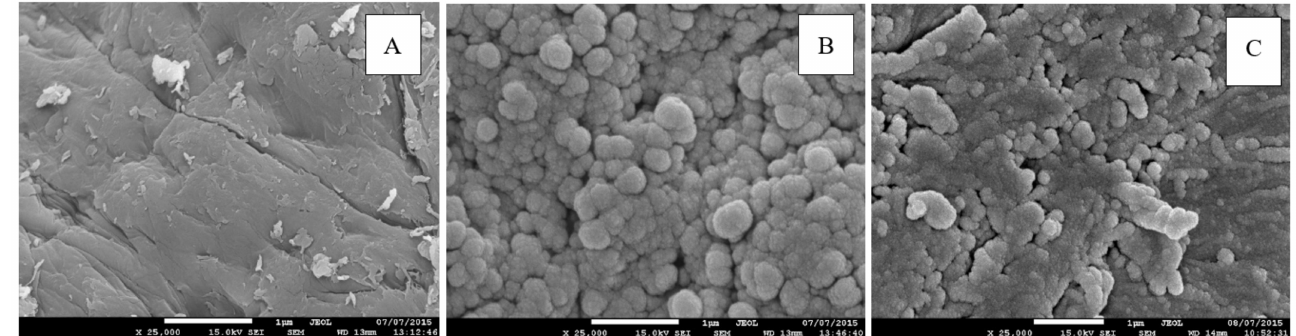
Figure 3. SEM micrographs of chitosan ( A ), ZnO nanoparticles ( B ), chitosan − ZnO nanocomposite 20 wt.% ( C ).